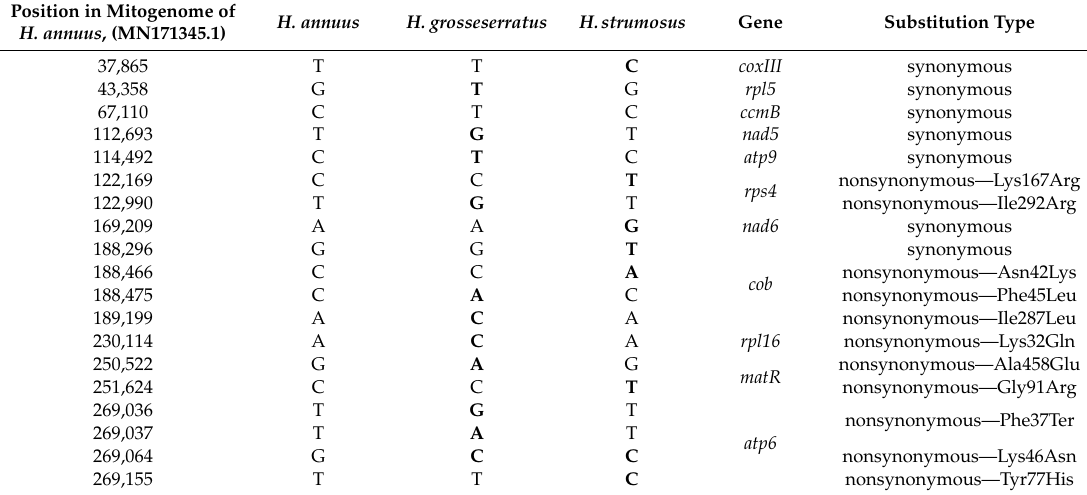
Table 1. Single nucleotide polymorphisms localized in protein-coding genes of perennial sunflower